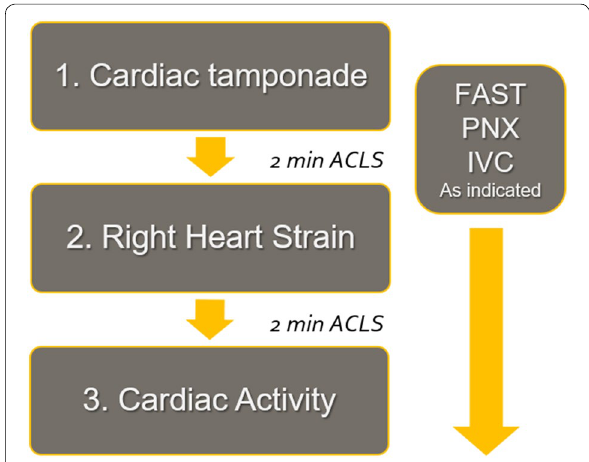
Fig. 1 The Cardiac Arrest Sonographic Assessment (CASA)